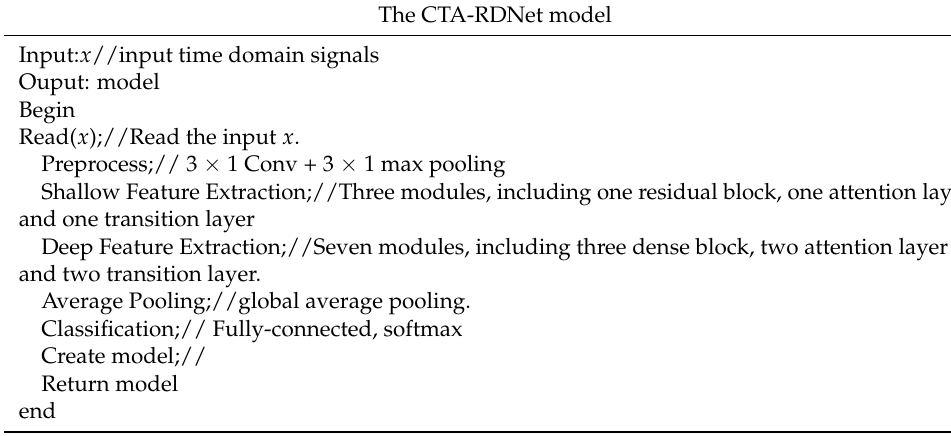
Table 2. Pseudocode for the CTA-RDnet